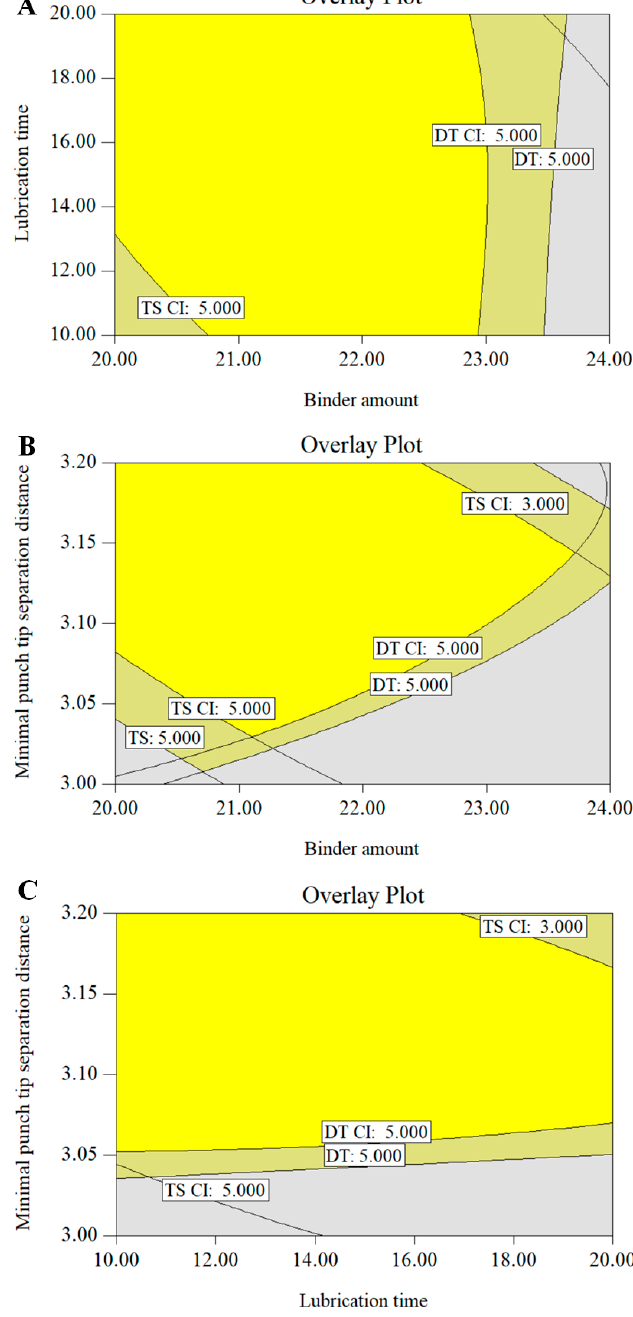
Figure 13. The design space for the PNS IRT production process; ( A ) binder amount vs. lubrication time; ( B ) binder amount vs. minimal punch tip separation distance; ( C ) lubrication vs. minimal punch tip separation distance.